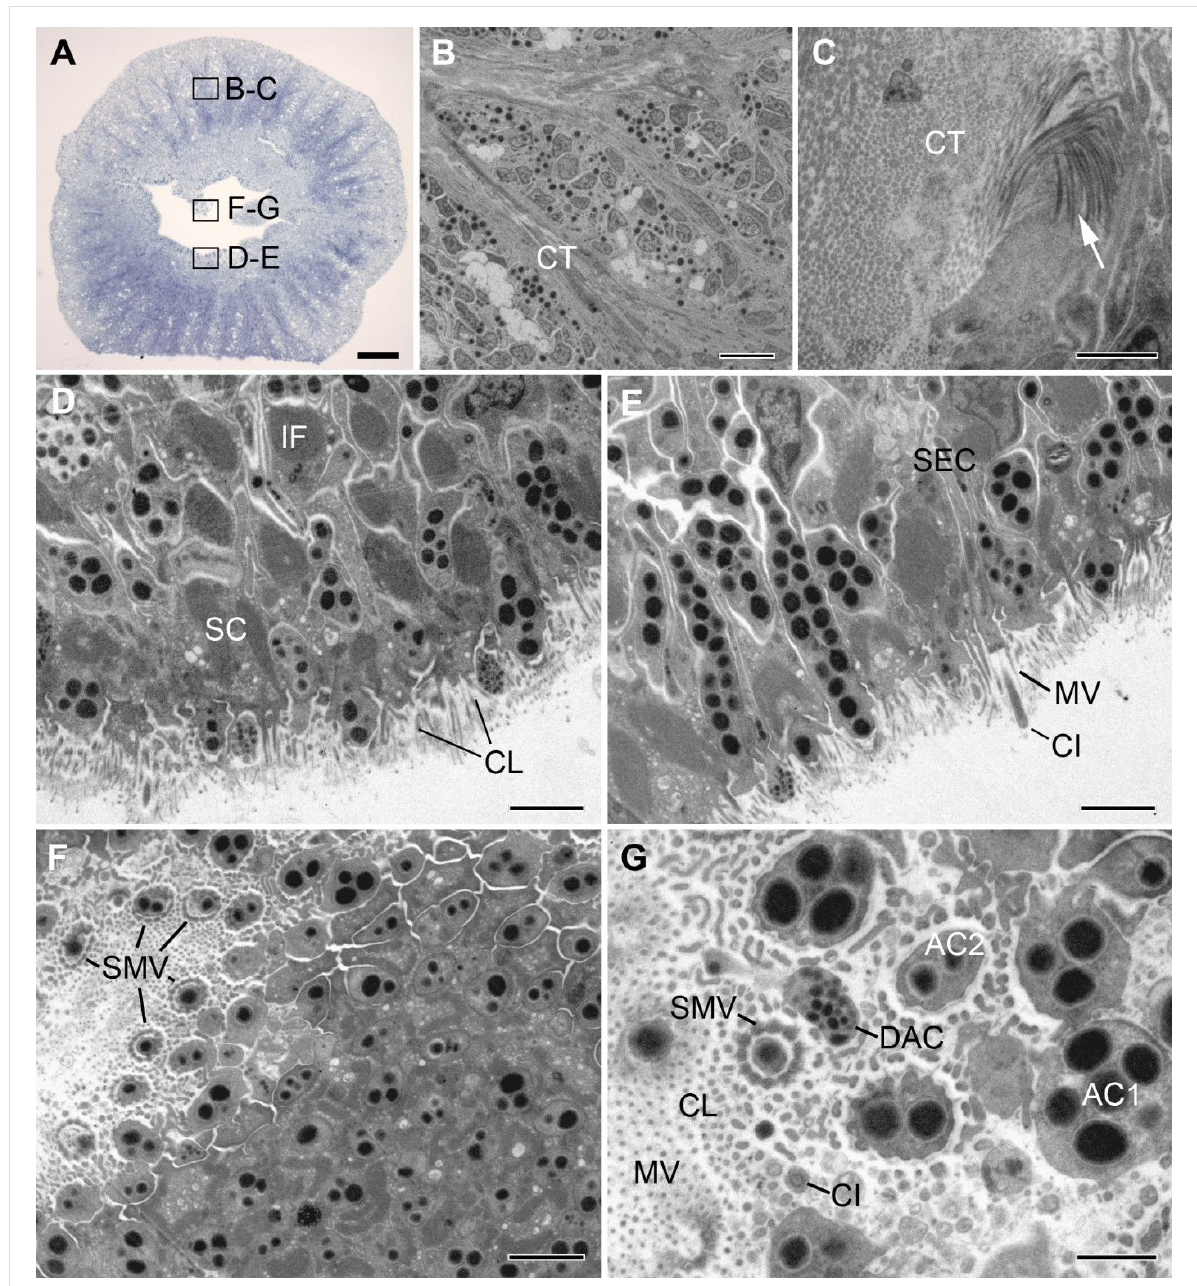
Figure 3: Ultrastructure of the tube foot adhesive epidermis of Asterina gibbosa observed in light microscopy (A) and TEM (B–G). (A) Semi thin cross- section of a tube foot at the level of the disc, boxes indicate approximate area of TEM images. (B–G) Ultrastructure of cells in the adhesive epidermis: (B,C) in the basal part of the disc, at the level of the connective tissue, and (D–G) in the apical part of the disc. Arrow in (C) highlights the collagen fibres of the connective tissue. AC - adhesive gland cell; CI - cilia; CL - cuticular layer; CT - connective tissue; DAC - de-adhesive gland cell; IF - inter- mediate filaments; MV - microvilli; SC - supportive cell; SEC - sensory cell; SMV - specialized microvilli. Scale bars: (A) 50 µm; (B) 5 µm; (C,G) 1 µm; (D,E,F) 2 µm.